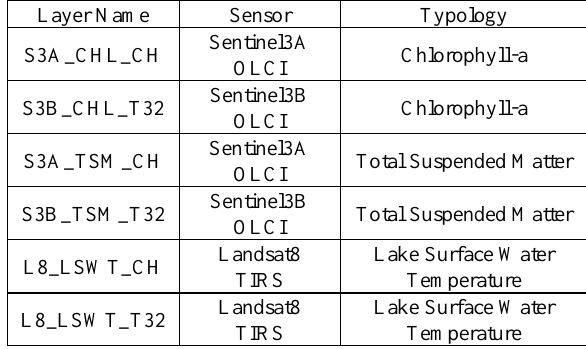
Table 3 - Processed water quality maps